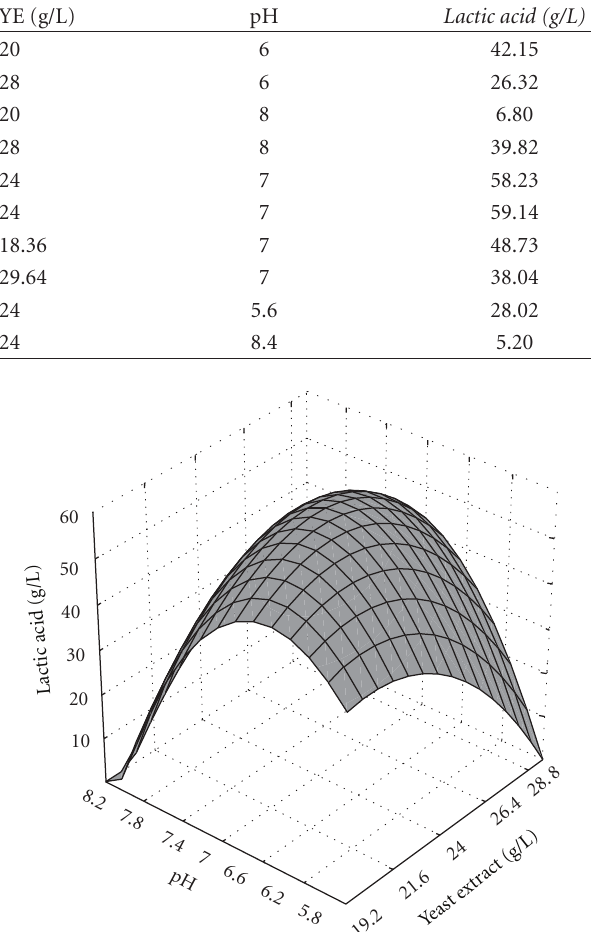
Figure 3: Response surface for lactic acid production as a function of the pH and of the yeast extract concentration ( T = 40 ◦ C, lactose 82g/L).